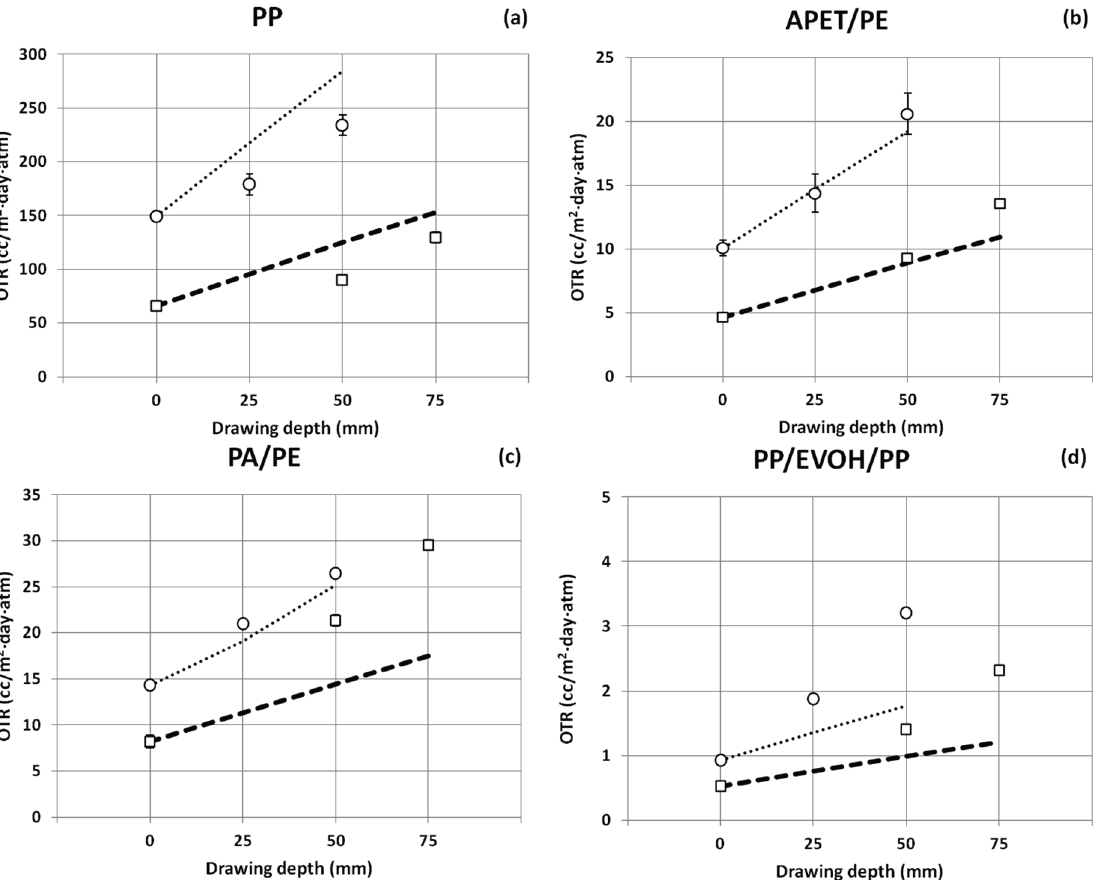
Figure 7. Measured and theoretical OTR in cc/m 2 ·day·atm as function of the deep drawn depth for ( a ) PP; ( b ) APET/PE; ( c ) PA/PE; ( d ) PP/EVOH/PP; ( e ) APET/PE/EVOH/PE; ( f ) PS/EVOH/PE; and ( g ) (PE/)PA/EVOH/PA/PE materials. Symbols ○ and □ represent the measured OTR of the thin and thicker sheet variant of each material, respectively. Dashed lines (····· and --- ) represent the theoretical OTR based on Equation (5) for the thin and thicker sheet variants,